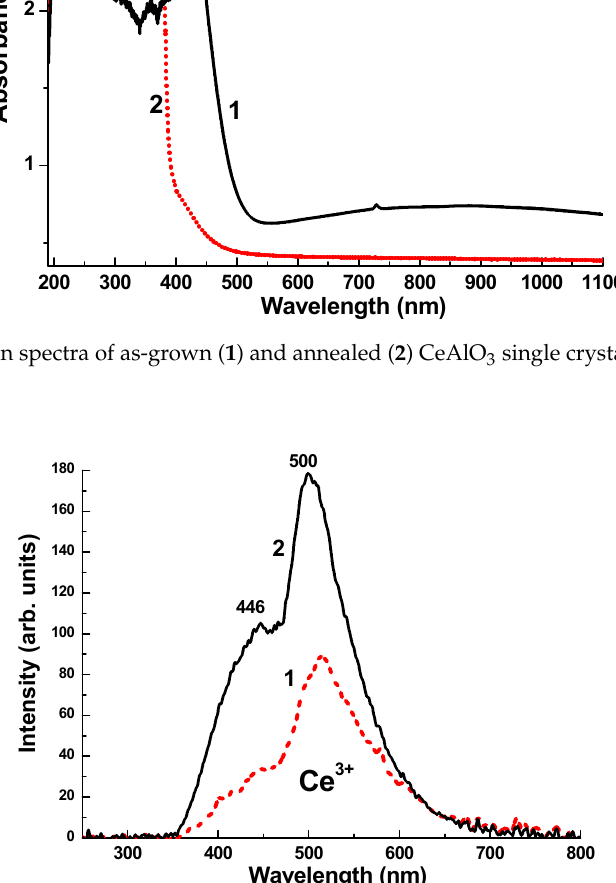
Figure 6. Absorption spectra of as-grown ( 1 ) and annealed ( 2 ) CeAlO 3 single crystals with a thickness of 1 mm.